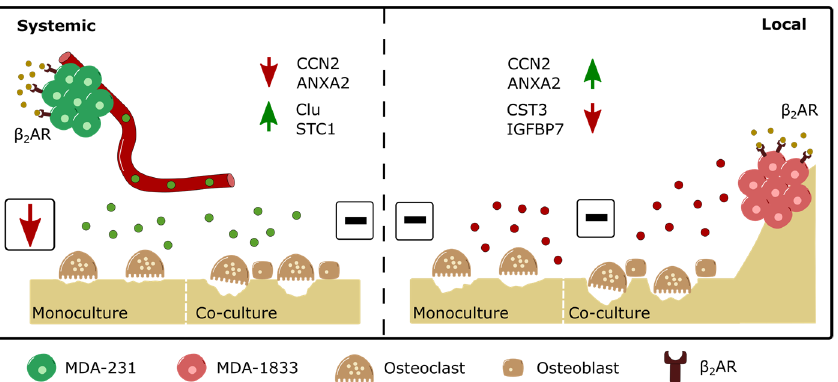
Figure 8. Schematic depiction of the differential modulation of osteoclast resorption activity by parental or bone tropic breast cancer cells. (Left panel) β 2-AR stimulation drives the upregulation of several proteins, such as Clu and STC1, and the downregulation of proteins such as CCN2 and ANXA2 in parental MDA-231 BC cells. Although exposure to the secretome of β 2-AR primed parental BC cells leads to decreased osteoclast resorption activity, the addition of osteoblasts to the model rescues osteoclast activity to control levels. (Right panel) on the other hand, the β 2-AR stimulation of bone tropic MDA-1833 cells leads to the upregulation of proteins such as CCN2 and ANXA2 and the downregulation of proteins such as CST3 and IGFBP7. The distinct modulation of protein expression by β 2-AR on bone tropic cells did not result in observable changes in osteoclast activity, either in monocultures or in co-cultures with